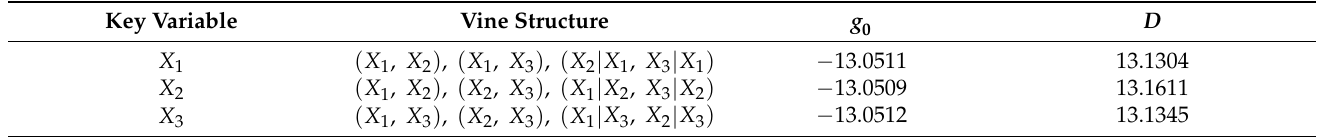
Table 4. Values of g 0 and D obtained by different C-Vine copulas ( N = 2 16